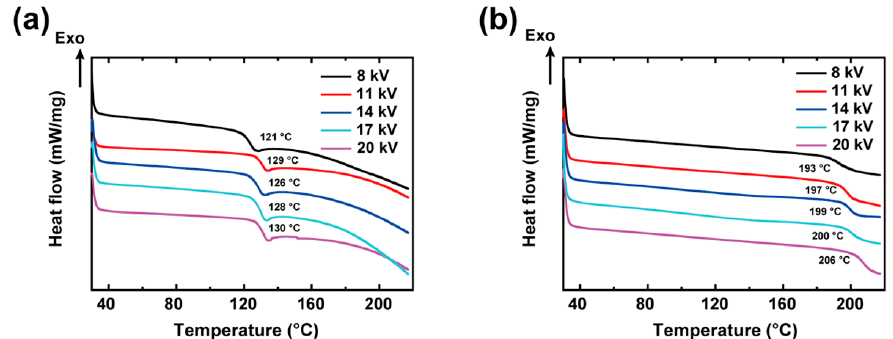
Figure 4. DSC curves of ( a ) as-spun PAA and ( b ) XLPAA NFs for various electrospinning voltages. The strong covalent bonds, which formed via crosslinking, increased the T g values. Polarized Raman spectroscopy was used to characterize the molecular chain conformations of individual nanofibers, which is involved in the orientation of molecular chains [29]. As shown in Figure 5a, a noticeable distinction between the parallel- and perpendicular-polarized Raman spectra was observed in the CH or CH 2 stretching band at 2935 cm − 1 (for all of the samples, see Figure S6 in the Supplementary Materials). Since the CH stretching mode is sensitive to the conformational change in PAA [23], the depolarization ratio ( ρ = 𝐼 (cid:2884) /𝐼 ∥ ) quantifies the relative populations of trans or gauche states in the backbone chains of PAA. Considering the abundance of trans states, the orientation of the as-spun PAA NFs may be highly aligned to the fiber-long axis. For instance, a previous study reported that the chain orientation of an electrospun poly(ethylene terephthalate) (PET) NF was aligned with the axis of the NF and proportionally correlated with the population of trans conformation [29]. The depolarization ratio results in Figure 5b indicate that the as-spun PAA NF at 14 kV possesses the highest amount of trans states. In contrast, it was impossible to resolve the depolarization ratios of the XLPAA NFs since the bands at 2935 cm − 1 lost the sharpness after crosslinking (Figure S6b in the Supplementary Materials). Figure 5. ( a ) Parallel- and perpendicular-polarized Raman spectra for an as-spun PAA NF at 14 kV and ( b ) depolarization ratio of as-spun PAA NFs as a function of electrospinning voltages. The depolarization ratio at 14 kV was the lowest value, which indicates the trans states of molecular chains were most populated at 14 kV.